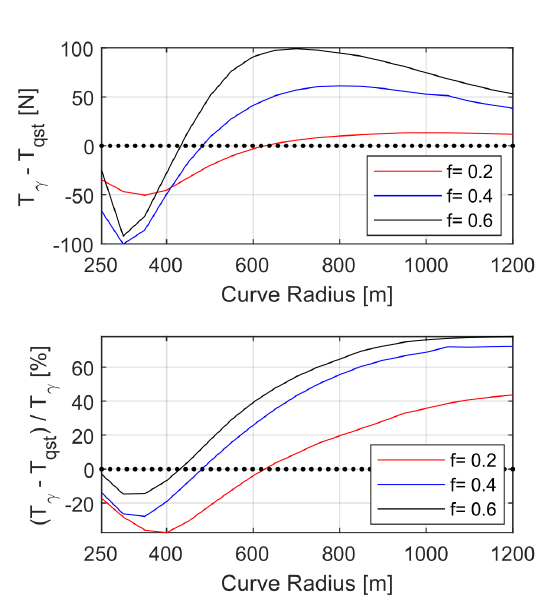
Figure 6. The difference T γ − T qst depending on the curve radius R (above) and the relative differ- ence ( T γ − T qst ) /T γ depending on the curve radius R (below) in the defined range of friction coefficient µ